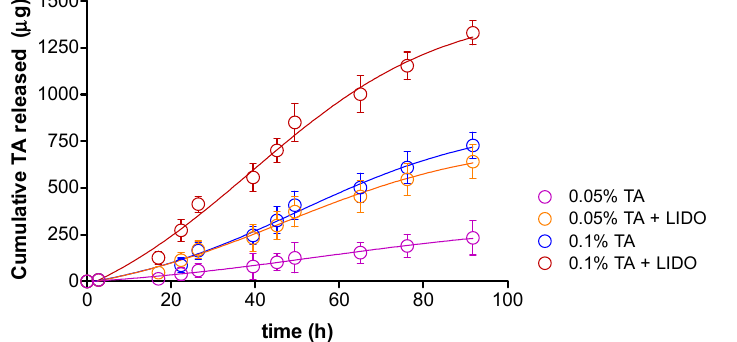
Figure 4. Cumulative amount ( µ g) of TA released versus time (h) from the four different formulations. Values represent Mean ± SD ( n = 3).